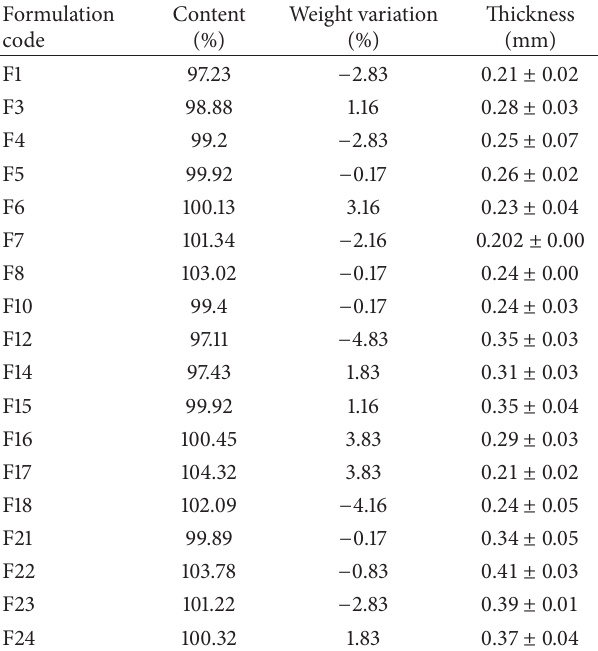
Table 3: Physicochemical characterization of OS of DSL ( 𝑛 = 10 ).